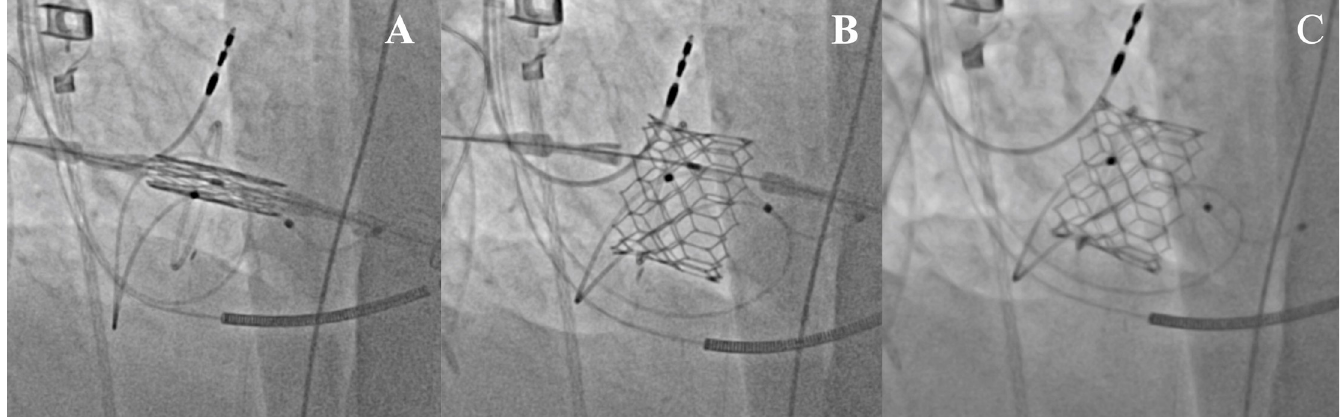
Fig 4. Transapical transcatheter mitral valve implantation valve-in-valve in a pre-shaped ‘docking´-station of known size. A–Positioning of the valve prosthesis in the annuloplasty ring. B–Deployment of the transcatheter valve prosthesis in the mitral position. C–Fully deployed valve prosthesis in the annuloplasty ring.